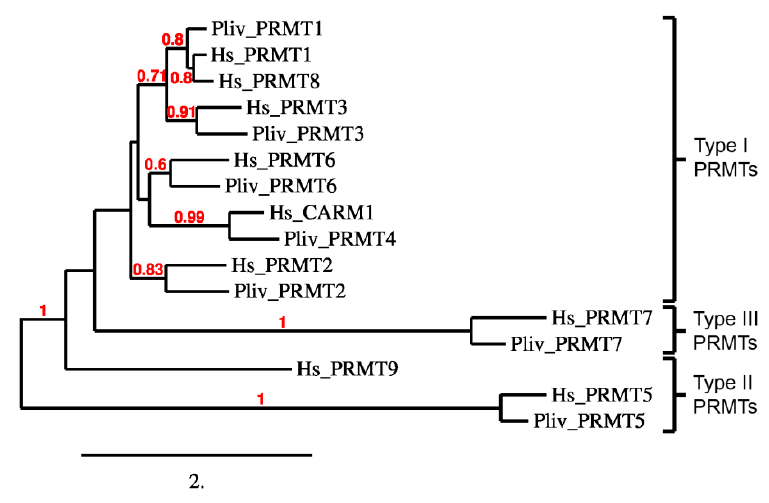
Figure 6. Amino acid sequences of P. lividus and Homo sapiens PRMTs were aligned and a distance tree was constructed. The tree was generated using MEGA X. The bootstrap consensus tree inferred from 1000 replicates is taken to represent the reliability of the branches of the analysed sequences. The percentage of replicate trees in which the associated taxa clustered together in the bootstrap test (1000 replicates) greater than 50% are shown in red next to the branches. Pairwise amino acid sequence alignment of human and P. lividus PRMTs are shown in Supplementary Materials Figures S1 and S2.